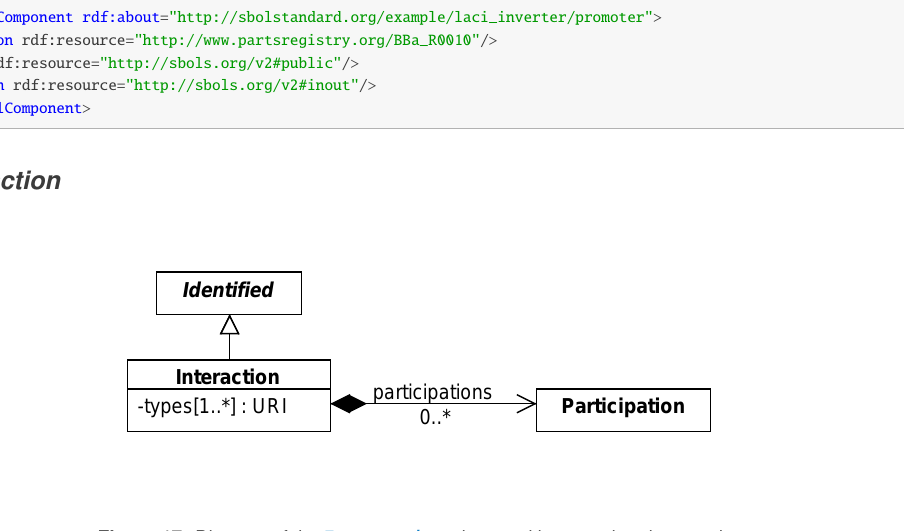
Figure 17: Diagram of the Interaction class and its associated